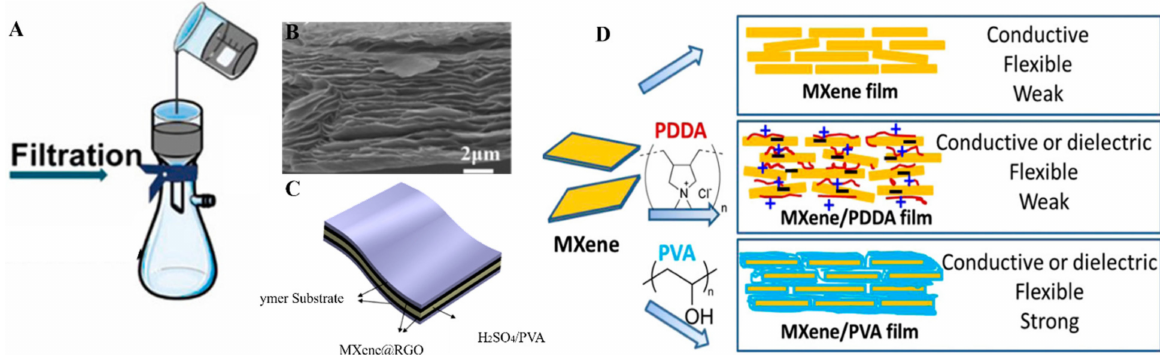
Figure 3. ( A ) VAF method for MXene thin films (reproduced with permission [56]. Copyright